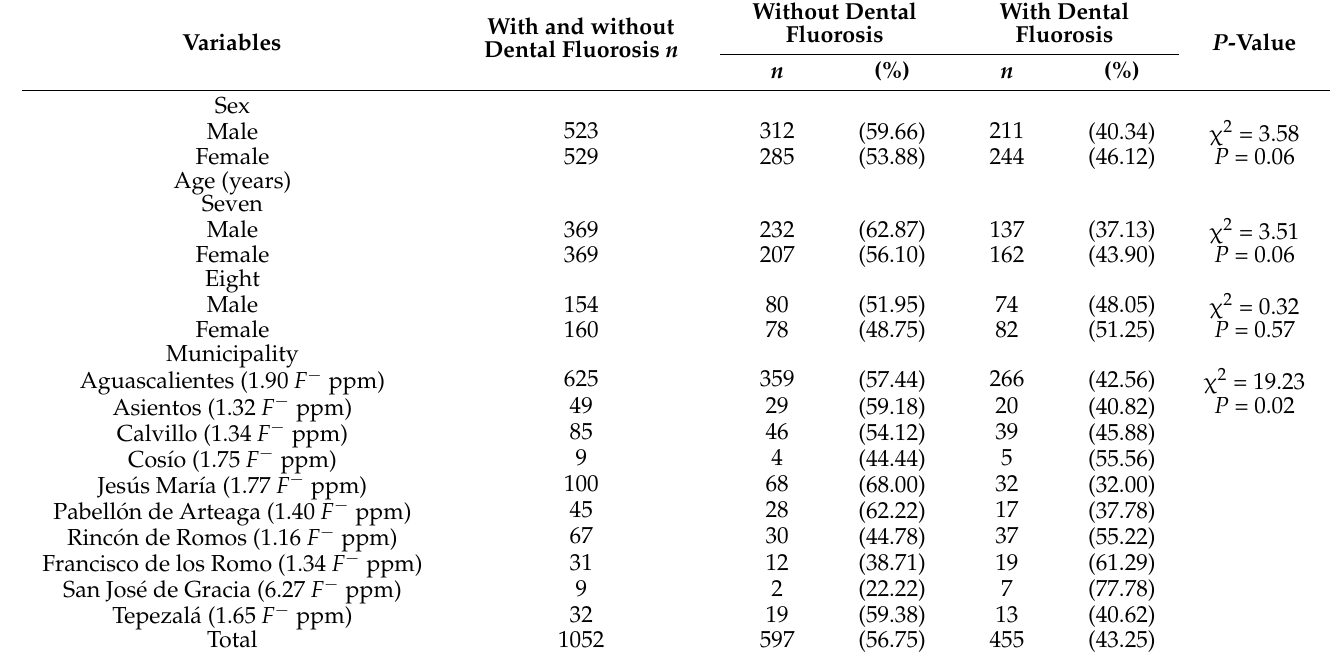
Table 1. Prevalence of dental fluorosis by sex, age, and municipality.